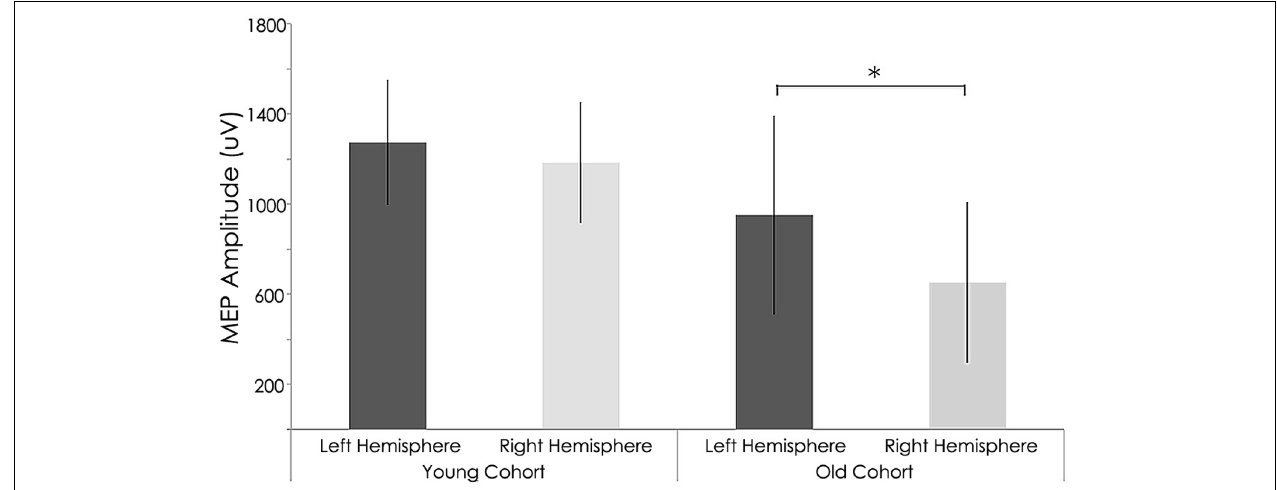
( p = 0 . 122; Wilcoxon signed-rank test); Statistically significant differences between right and left hemispheres among older subjects ( p = 0 . 004; Wilcoxon signed-rank test). ∗ , statistically significant ( p < 0 . 05).